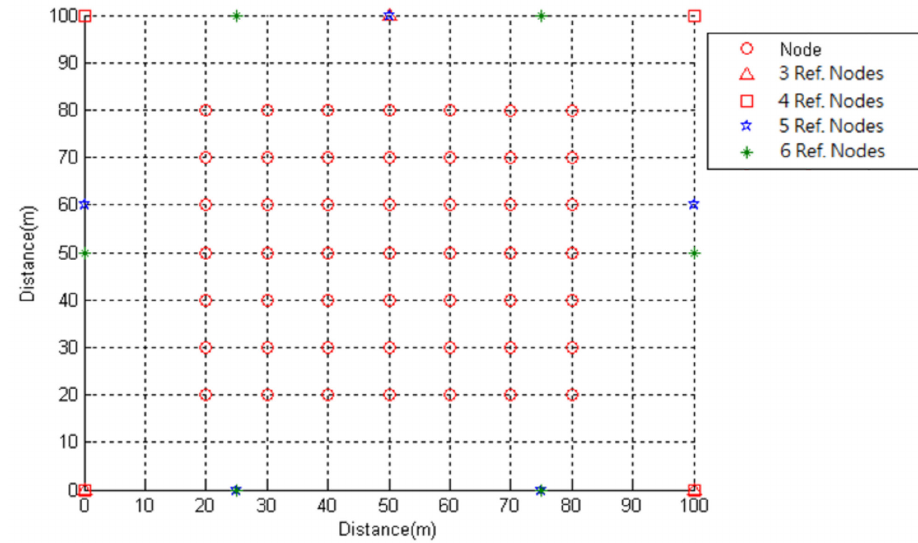
Figure 9. Three, four, five, and six reference nodes for a small range.